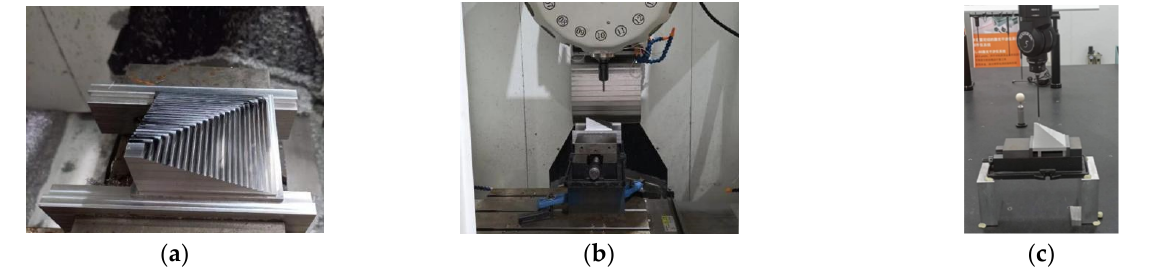
Figure 15. Machining and measurement of the test piece. ( a ) Clamping. ( b ) Machining. ( c ) Measurement.